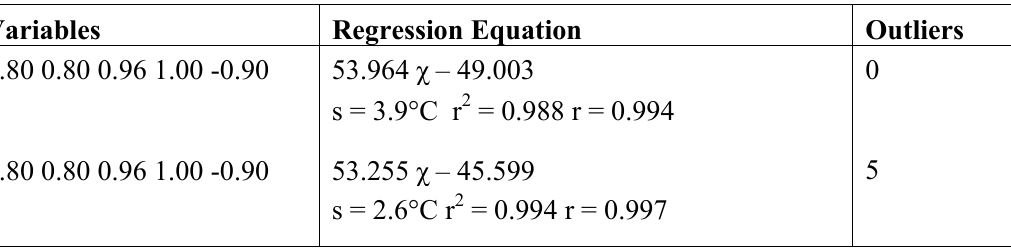
Table 4. The regression equation based on differentiation between primary, secondary, tertiary and quaternary carbon atoms. In the lower part of the table regression equation was listed when five outliers have been removed from the set of n = 58